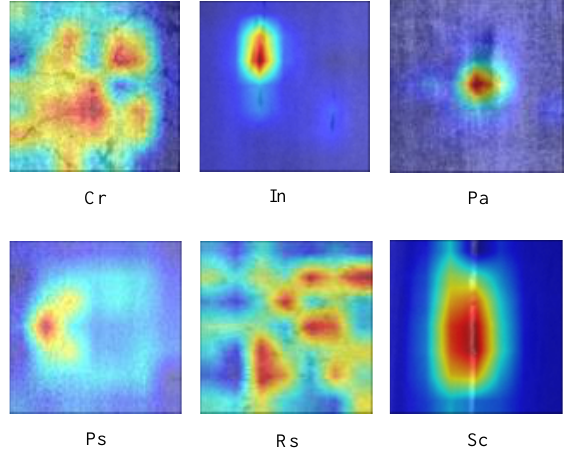
Figure 11. KD-EG-RepVGG network heat map.